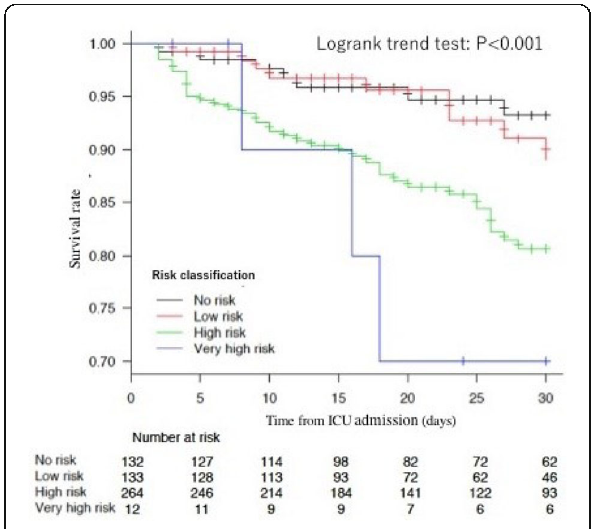
Fig. 1 (abstract 000663). See text for